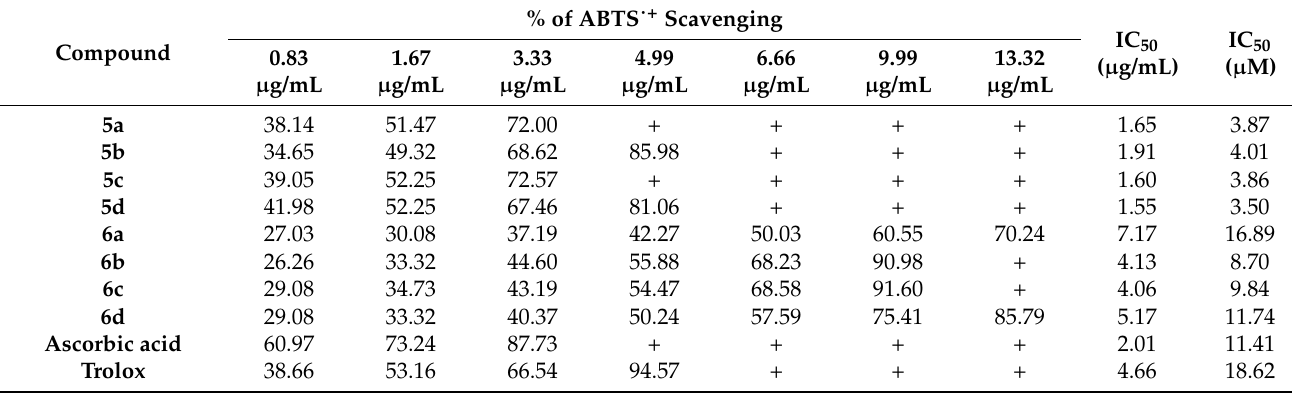
Table 1. Results of the ABTS ˙ + scavenging